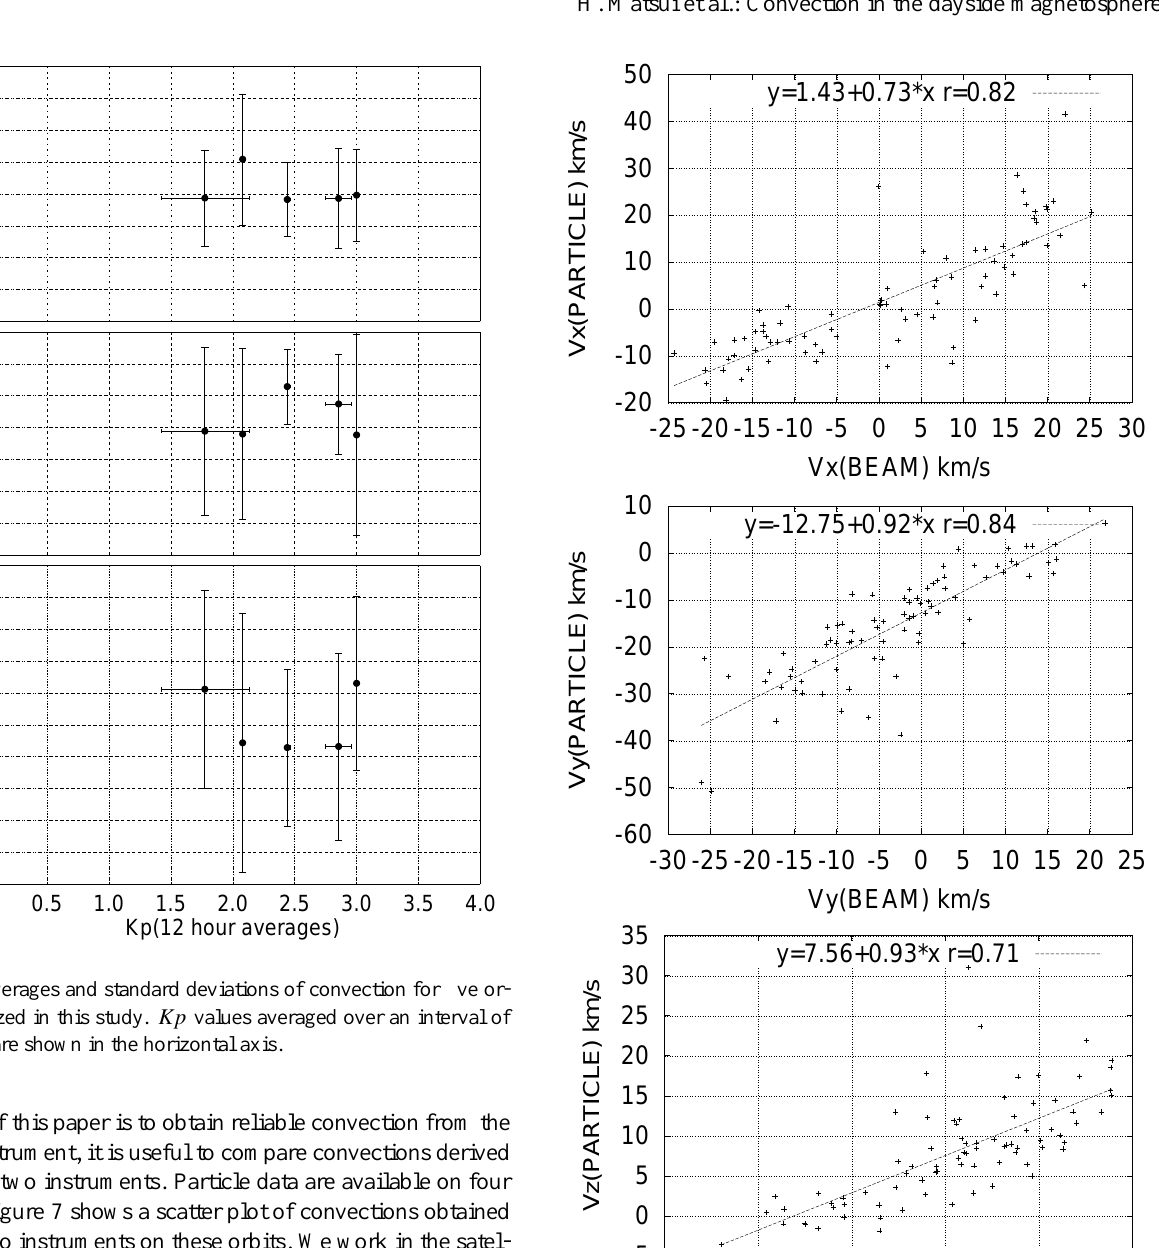
Fig. 6. Averages and standard deviations of convection for five or- bits analyzed in this study. Kp values averaged over an interval of 12 hours are shown in the horizontal axis.